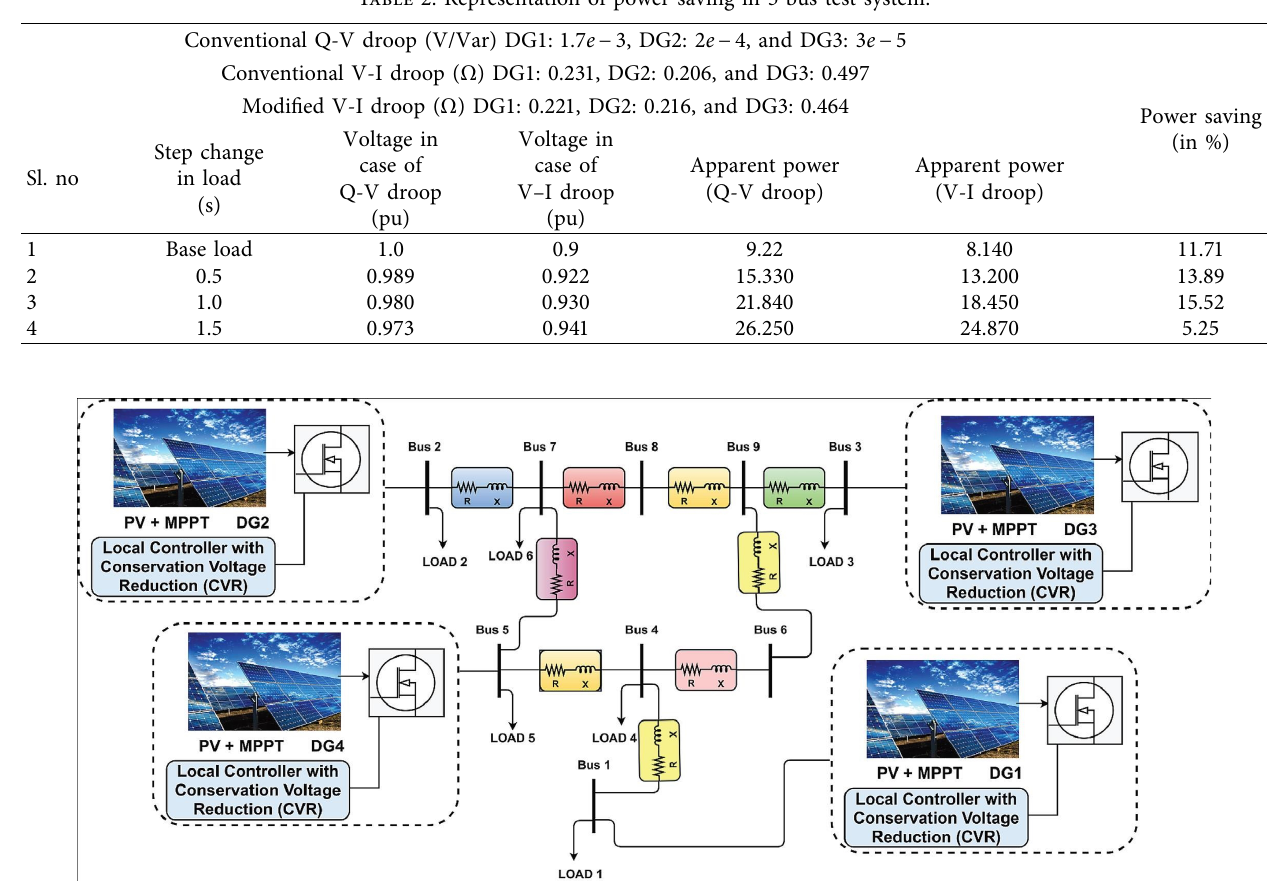
Table 2: Representation of power saving in 5 bus test system.